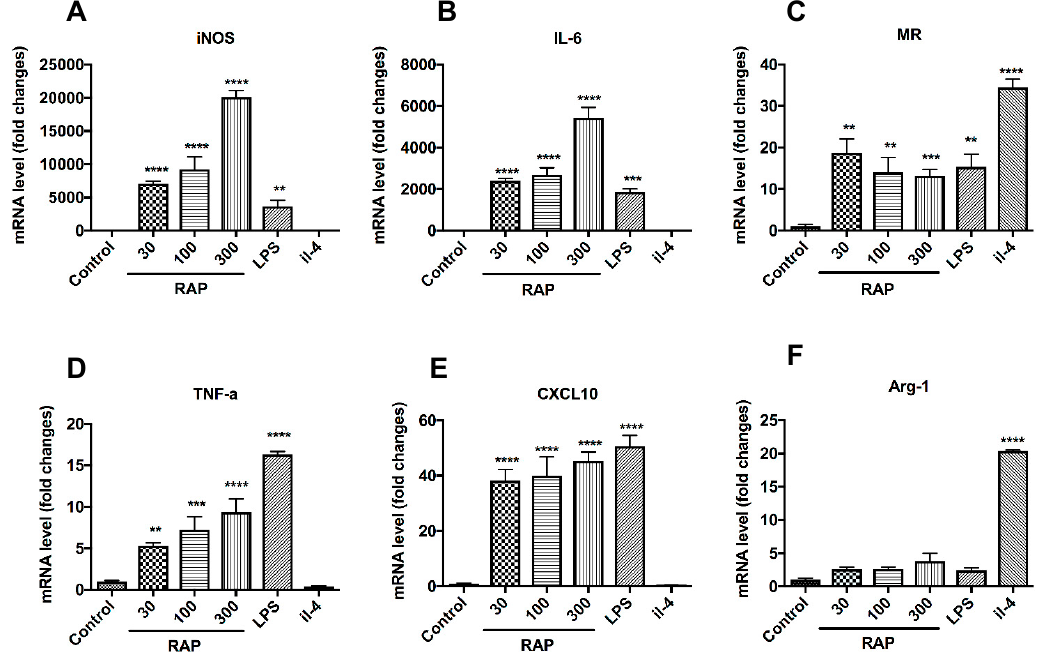
Figure 3. The expression of M1 and M2 markers in BMDMs induced by RAP and IL-4 was evaluated by qRT– PCR. BMDMs were treated with 30 μ g/mL, 100 μ g/mL, and 300 μ g/mL of RAP, 1 μ g/mL of LPS, and 20 ng/mL of IL-4 for 24 h. Total RNA was extracted and the mRNA levels of iNOS ( A ), IL-6 ( B ), MR ( C ), TNF- α ( D ), CXCL10 ( E ), and Arg1 ( F ), were determined by qRT-PCR. Data represent fold induction of mRNA expression compared with control group. A significant difference of each gene expression in each group was observed by one-way ANOVA test, **** p < 0.0001, *** p < 0.001, ** p < 0.01.